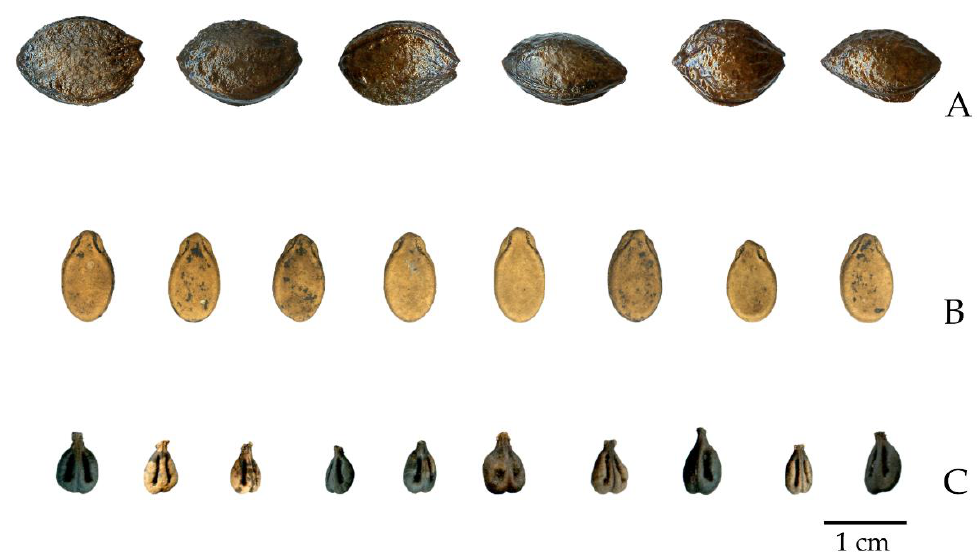
Figure 3. Representative image of some of the archaeological samples used in this work: ( A ) Prunus domestica ; ( B ) Citrullus lanatus var. lanatus ; ( C ) Vitis vinifera subsp. vinifera .